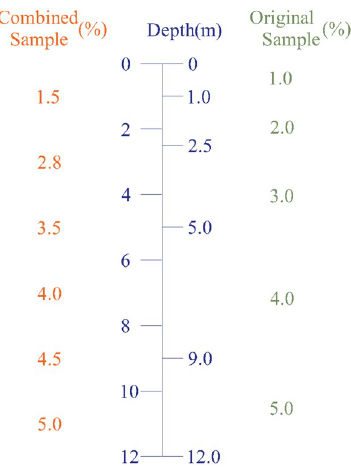
Figure 3. Schematic showing the sample